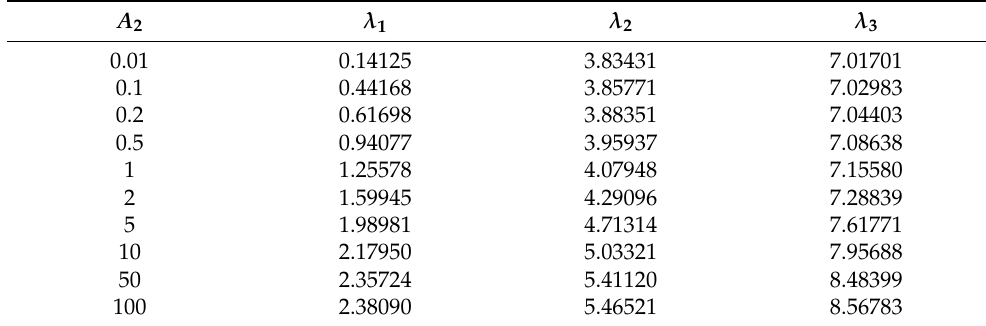
Table 1. The numerical values of λ 1 , λ 2 , and λ 3 of Equation (24) at different values of A 2 .